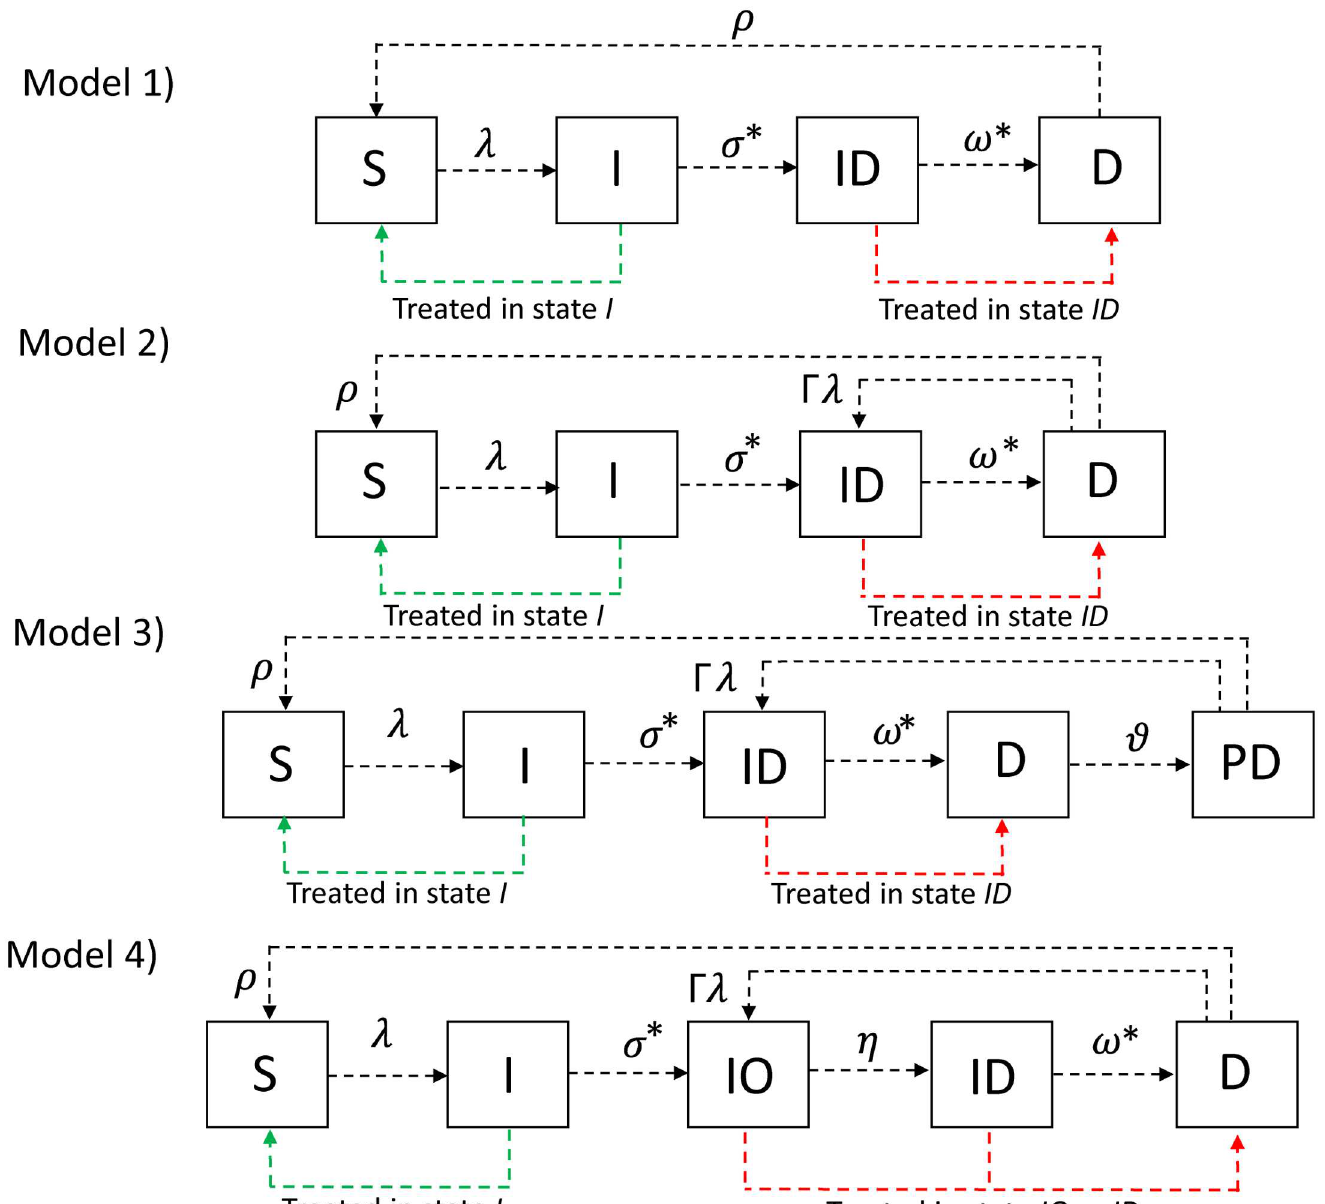
Fig 1. Schematic of the different model structuresevaluated. A) RepresentsModel 1, here individualsin the D are 100% immune to re-infection. B) RepresentsModel 2, where individualsin the D state can be re-infected. C) RepresentsModel 3 [18], where individuals are 100% immune to re-infection in the D state but can be re-infectedonce they progress to the PD state. D) RepresentsModel 4 where individualsin the IO state spenda period of time only PCR positive, then progress to ID where they are PCR and TF positive. Colouredarrows illustrate how treatment within each model structure is implemented. Individuals who are infected but not infectiouswhen treated return to the S i class they were in before they were infected (indicated by the red arrow), henceno immunity is acquired as a result of infection. For those in the ID i or IO i class who are successfully treated they progress to the D (indicatedby the green arrow) and were assumed to acquire immunity as a consequence of the infectionthey experienced. Treatment was assumed to not impact those in the diseaseonly states. The ( * ) aroundparameters indicatethat the minimumrate of recovery of these parameters was estimated.